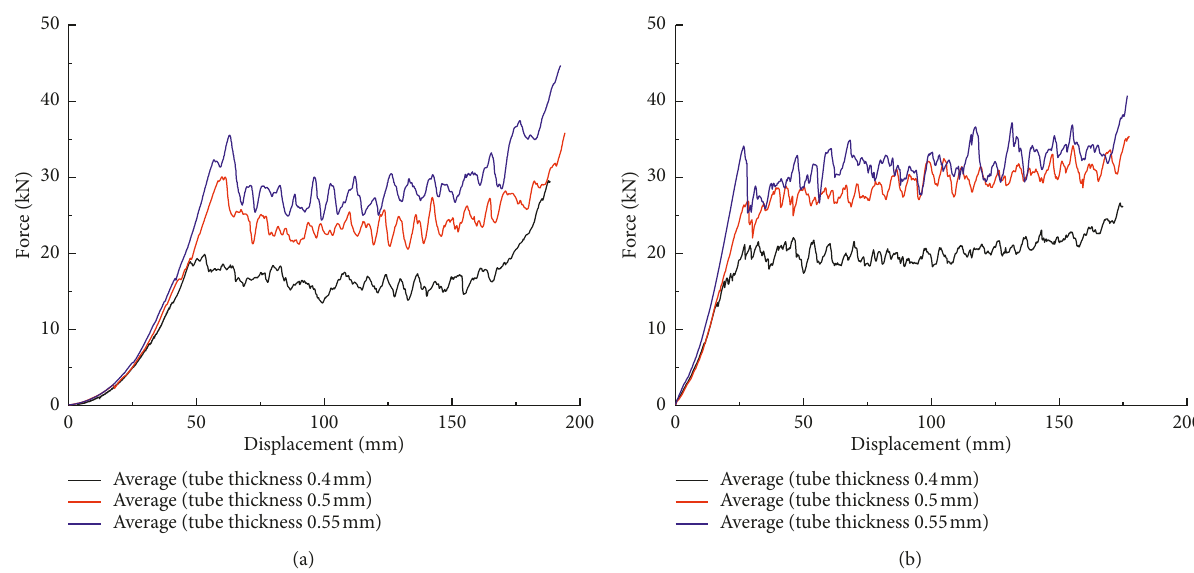
Figure 11: Average quasistatic tensile load-displacement curves of the dissipators with different tube thicknesses. (a) Tube-crushing dissipators. (b) Symmetric tube-crushing dissipators.